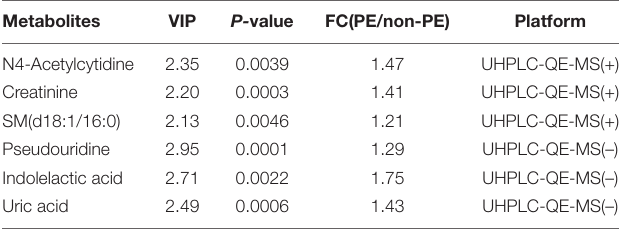
TABLE 2 | Metabolites observed to be significantly different between PE and non-PE groups.